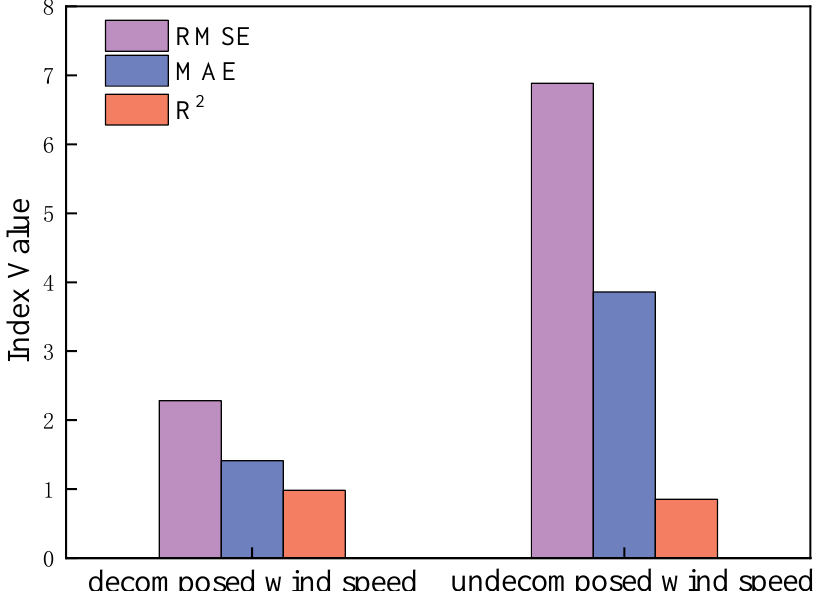
Figure 10. Evaluation indexes chart with and without decomposing wind speed.